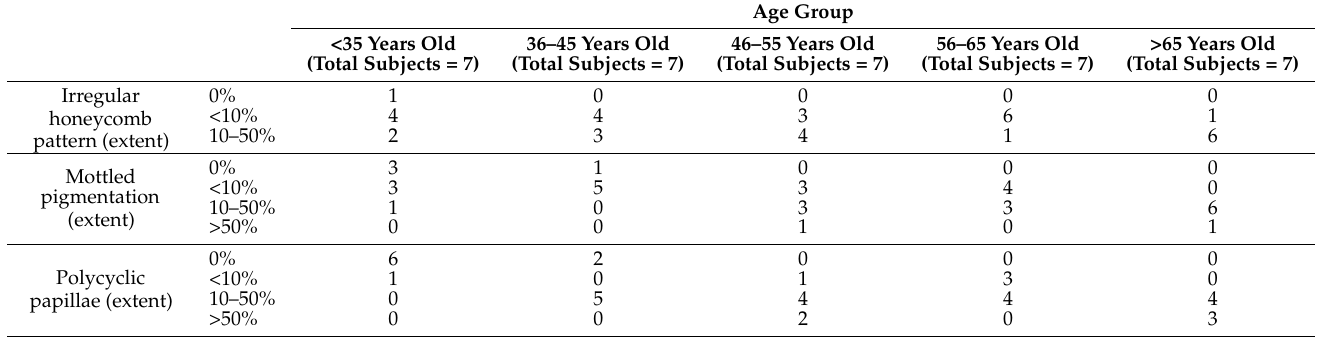
Table 5. The extent of an irregular honeycomb pattern, mottled pigmentation, and polycyclic papillae in different age